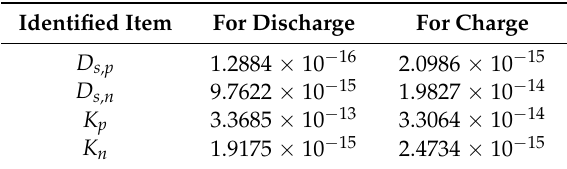
Table 5. Identified items for over-charge (OC)